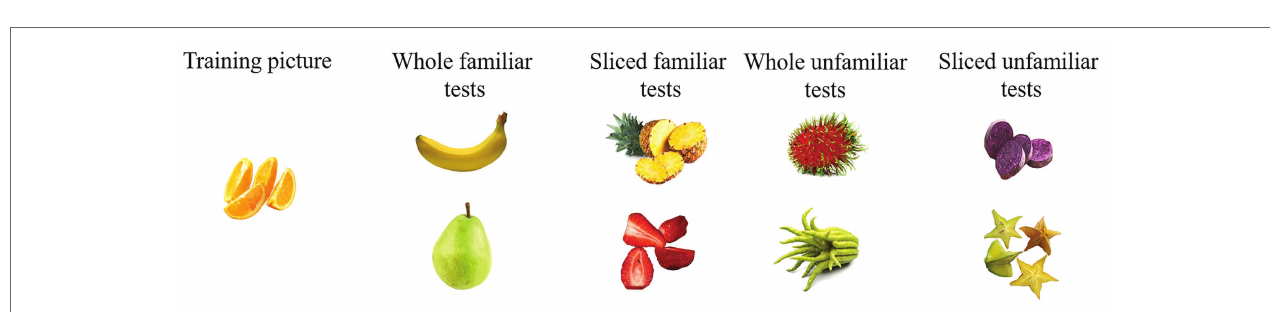
FIGURE 1 | Pictures of Feppy used in the property generalization task.